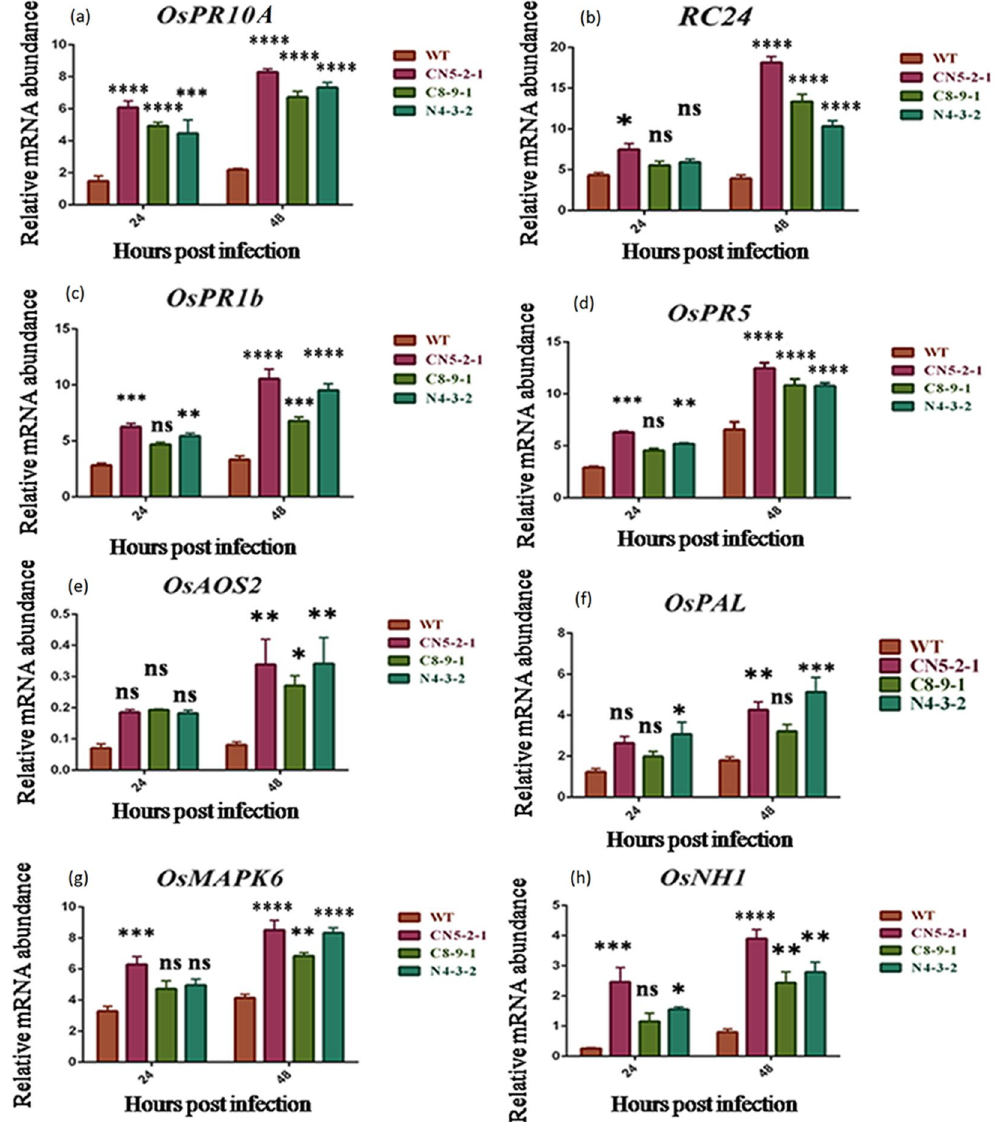
Figure 3. Real-time PCR analysis of some differentially expressed PR , SA and JA pathway genes in single transgene containing as well as pyramided rice lines. Total RNA isolated from leaves of both transgenic T 2 and non-transformed WT plant, inoculated with sheath blight fungus R . solani , and harvested at 24 and 48 hpi (hours post infection). Experiment performed by SYBR green-based quantitative real-time PCR, using β -tubulin as internal control. Expression of ( a ) PR10A, ( b ) RC24, ( c ) OsPR1b, ( d ) OsPR5, ( e ) OsAOS2, ( f ) OsPAL , ( g ) OsMAPK6 and ( h ) OsNH1 gene in transgenic and wild type plants. Each bar represents the mean ± SE of three independent